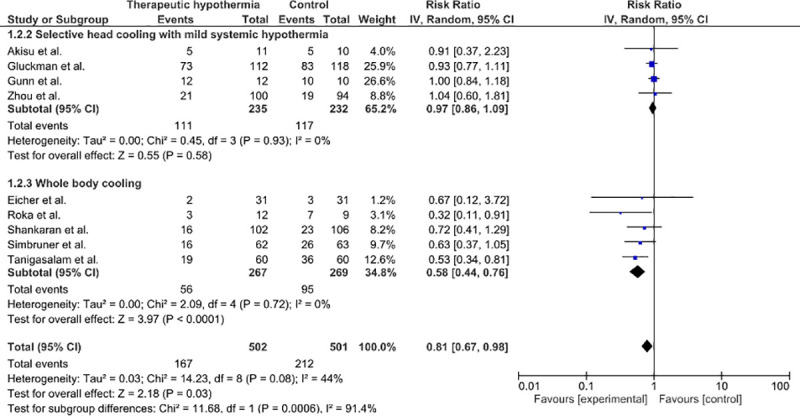
Forest plot of the effect of hypothermia on the incidence of AKI in asphyxiated neonates, expressed in risk ratios.Subgroup selective head cooling with mild systemic hypothermia: there is no significant difference between cooled and non-cooled neonates. Subgroup whole body cooling: there is a significant difference between cooled and non-cooled neonates.